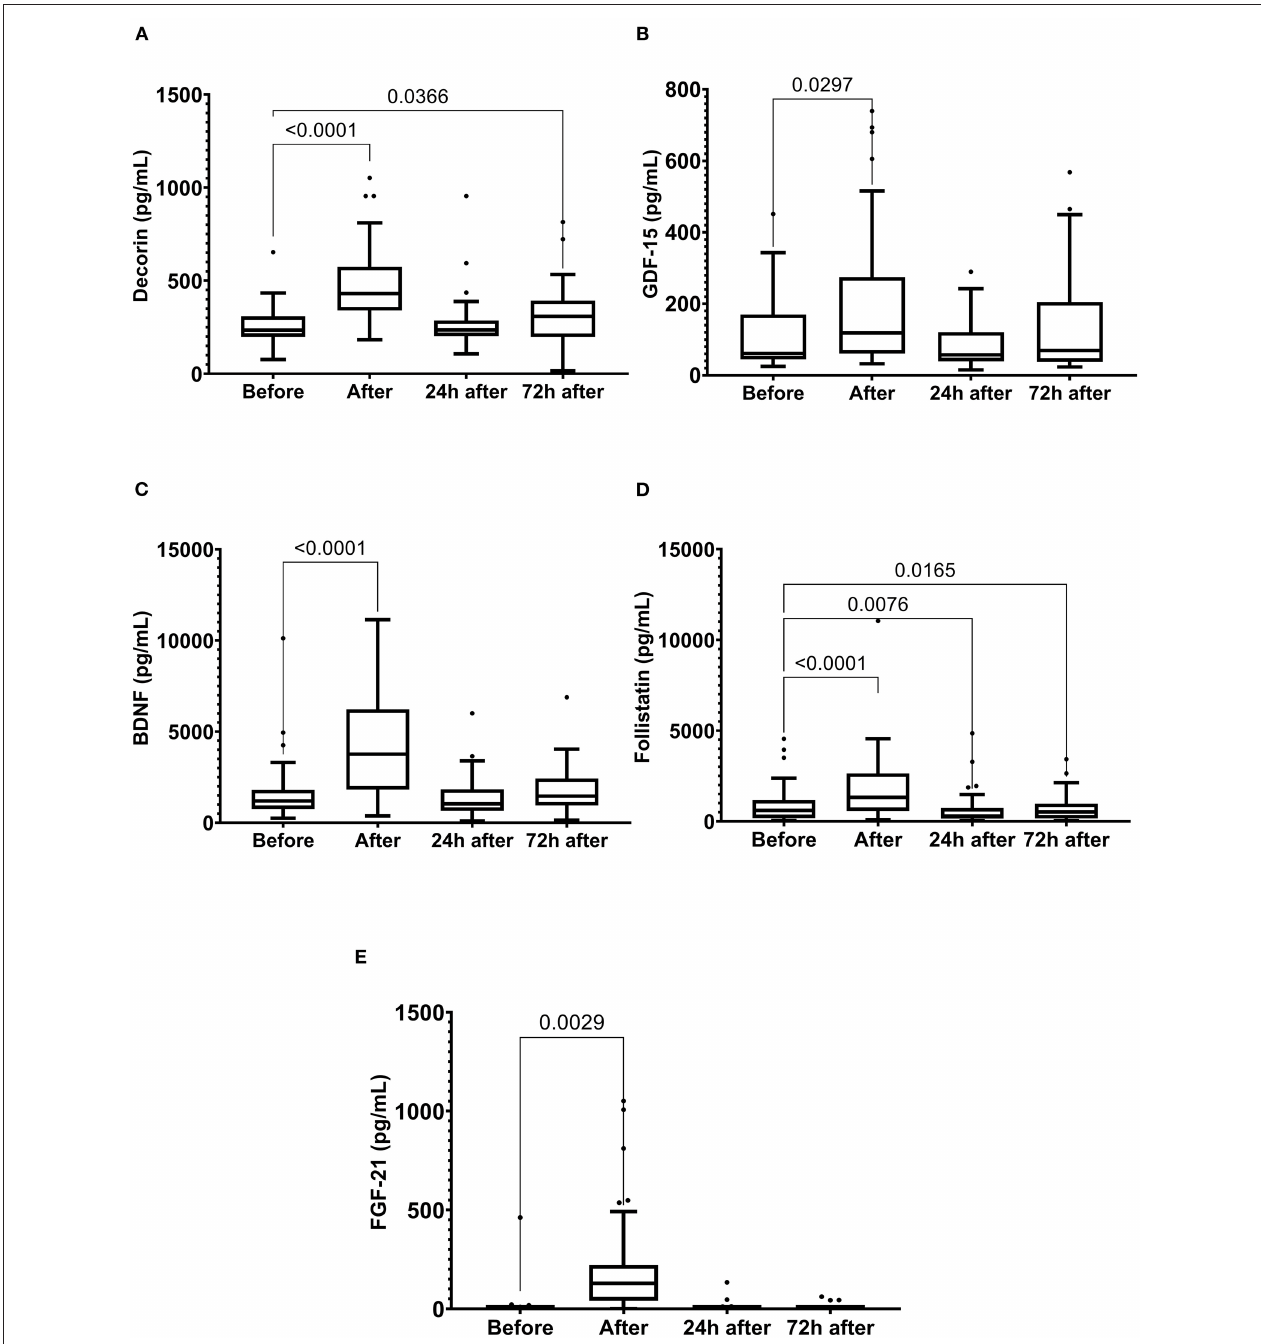
FIGURE 5 | The plasma levels of decorin (A) , growth differentiation factor 15 (GDF-15) (B) , brain-derived neurotrophic factor (BDNF) (C) , follistatin (D) fibroblast growth factor 21 (FGF-21) (E) immediately after, 24h after, and 72h after the race. The values are presented as minimum, maximum, median, and outliers of 48 runners (decorin, GDF-15, BDNF, and Follistatin) or 40 runners (FGF-21) (Box plot, Tukey).